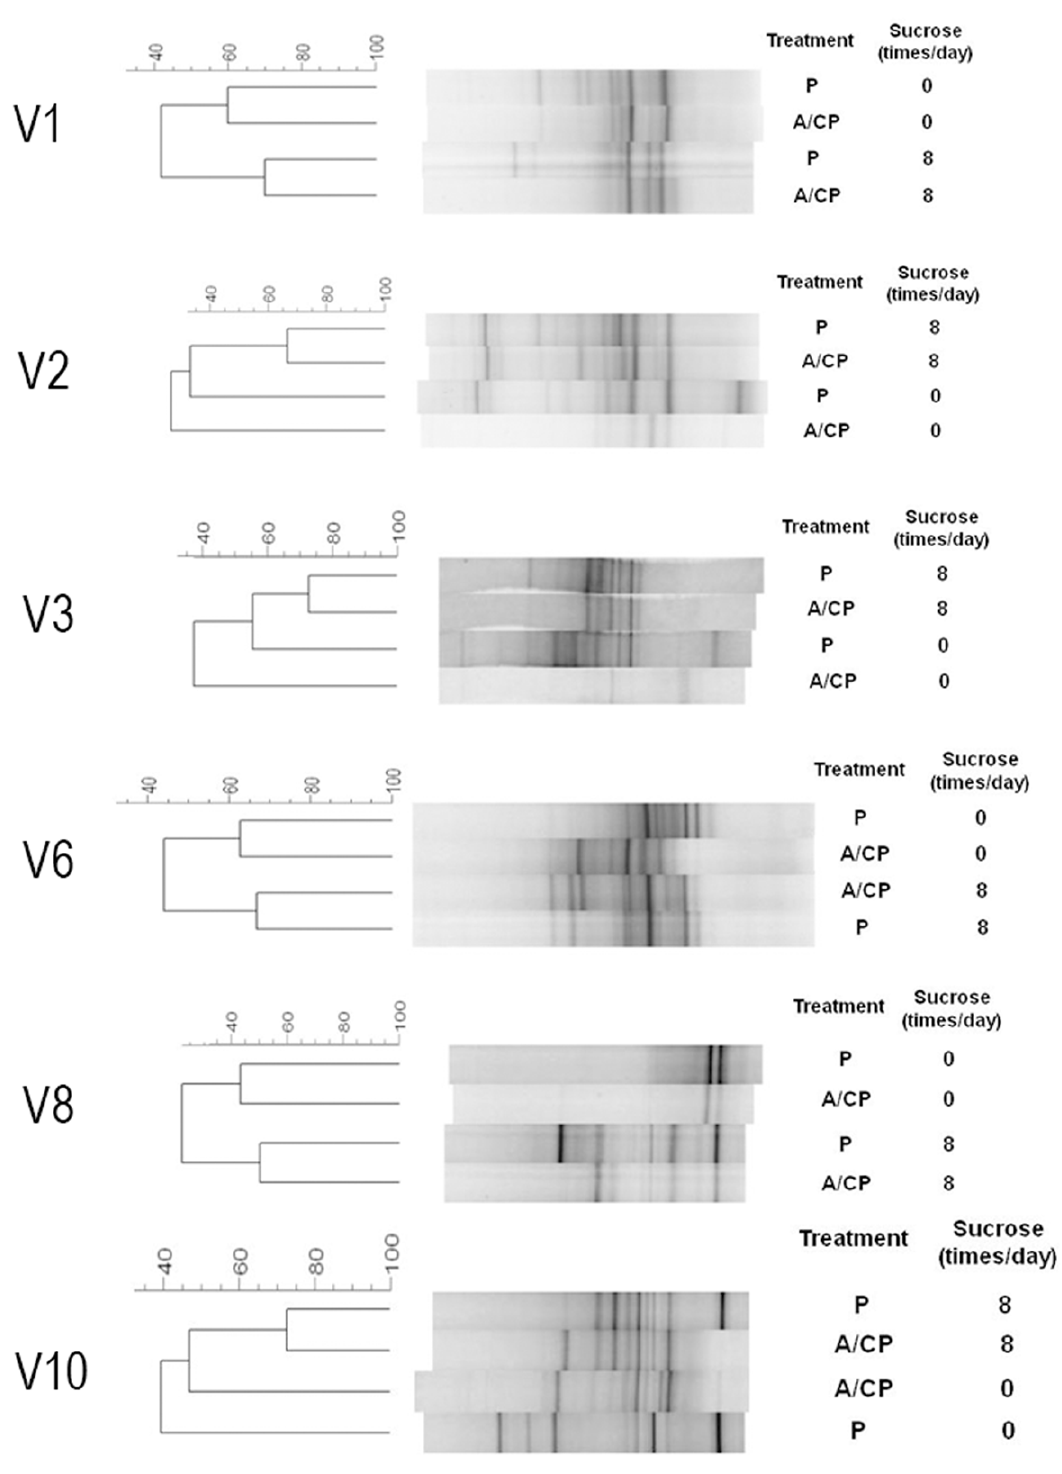
Figure 2. DGGE profiles of PCR-amplified bacterial 16S rDNA gene fragments from biofilm samples of six volunteers. All samples were treated with Placebo (P) or Amoxicillin/Clavulanate Potassium (A/CP) without additional sucrose exposure (0) and at an 8-time daily frequency of 20% sucrose exposure. Comparisons were made for the same volunteer.